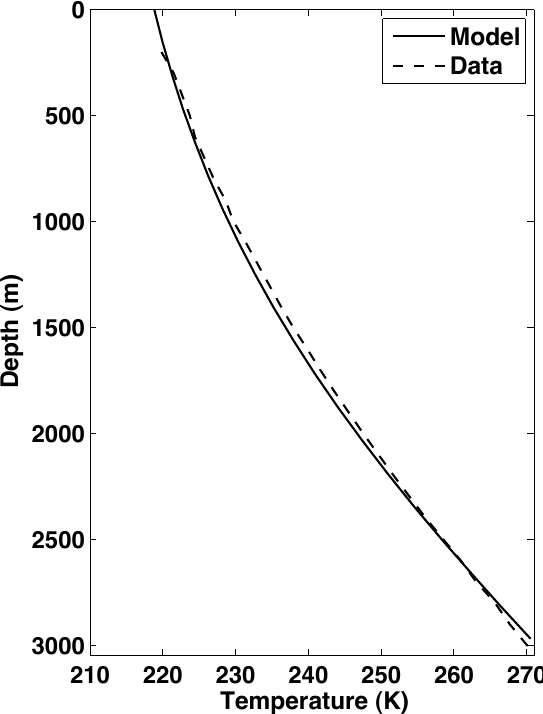
Fig. 11. Anisotropic steady-state simulation: Profile of the tem- perature at the Dome Fuji drill site (solid line). The dashed line shows data measured in the field season 2006/2007 (H. Motoyama, personal communication,